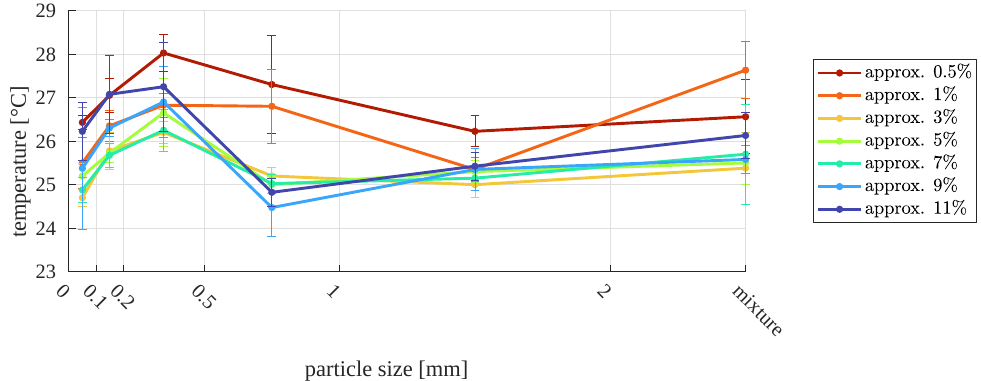
Figure 16. Surface temperature as a function of particle size, for different relative moistures—second approach (normal images).